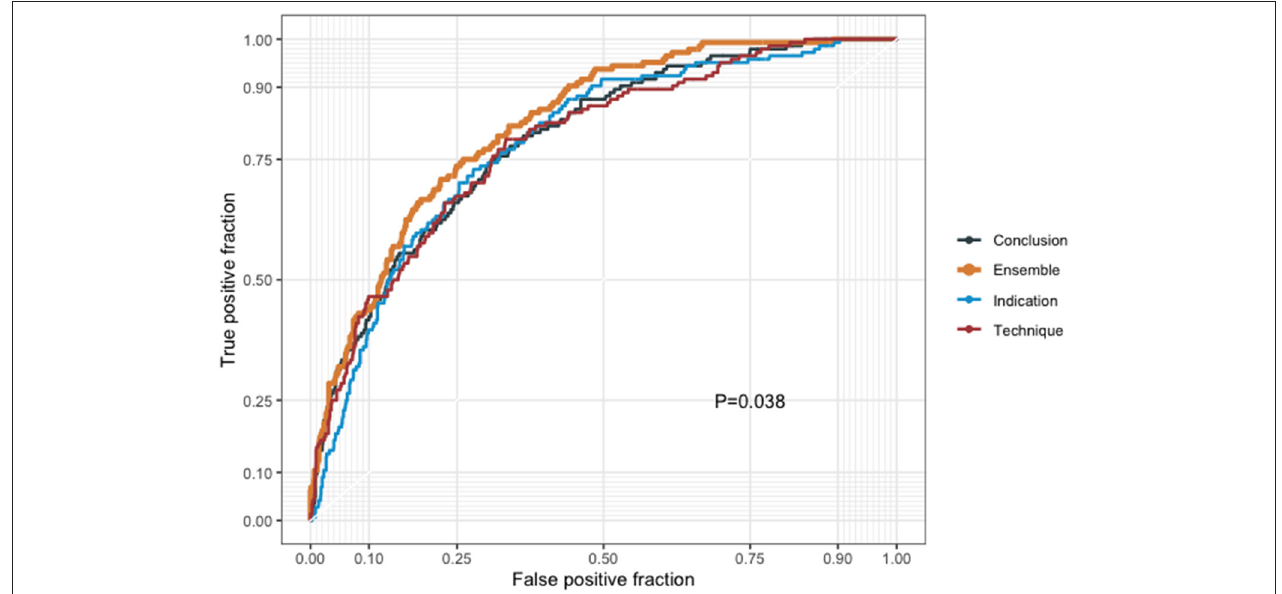
FIGURE 4 | Receiver operating characteristic curves of the results from our model training with the indication, technique, and conclusion parts alongside the results from the combination of the three models.